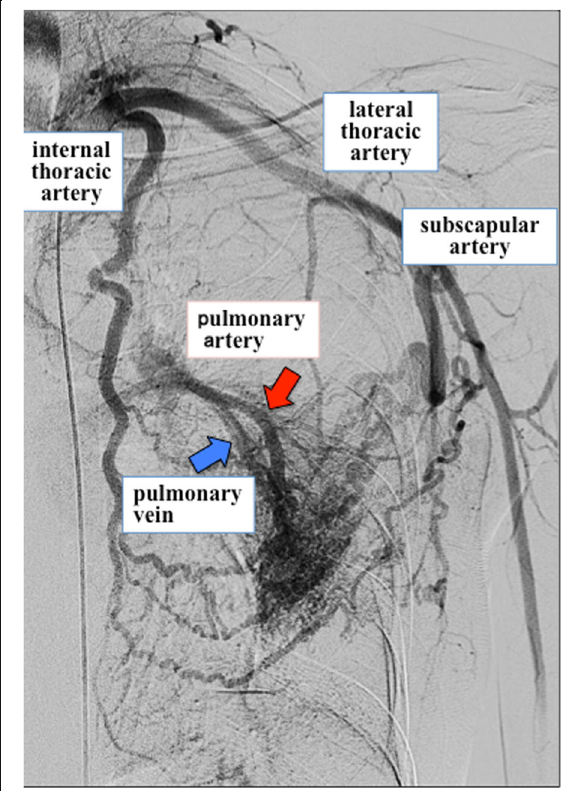
Fig. 3 Left subclavian selective arteriogram findings. A left subclavian selective arteriogram, showing hypertrophic blood vessels that arose from the internal thoracic artery, the lateral thoracic artery, intercostal artery, and the subscapular artery arising from the axillary artery and drained into both the pulmonary artery (red arrow) and the pulmonary vein (blue arrow) in the lingular